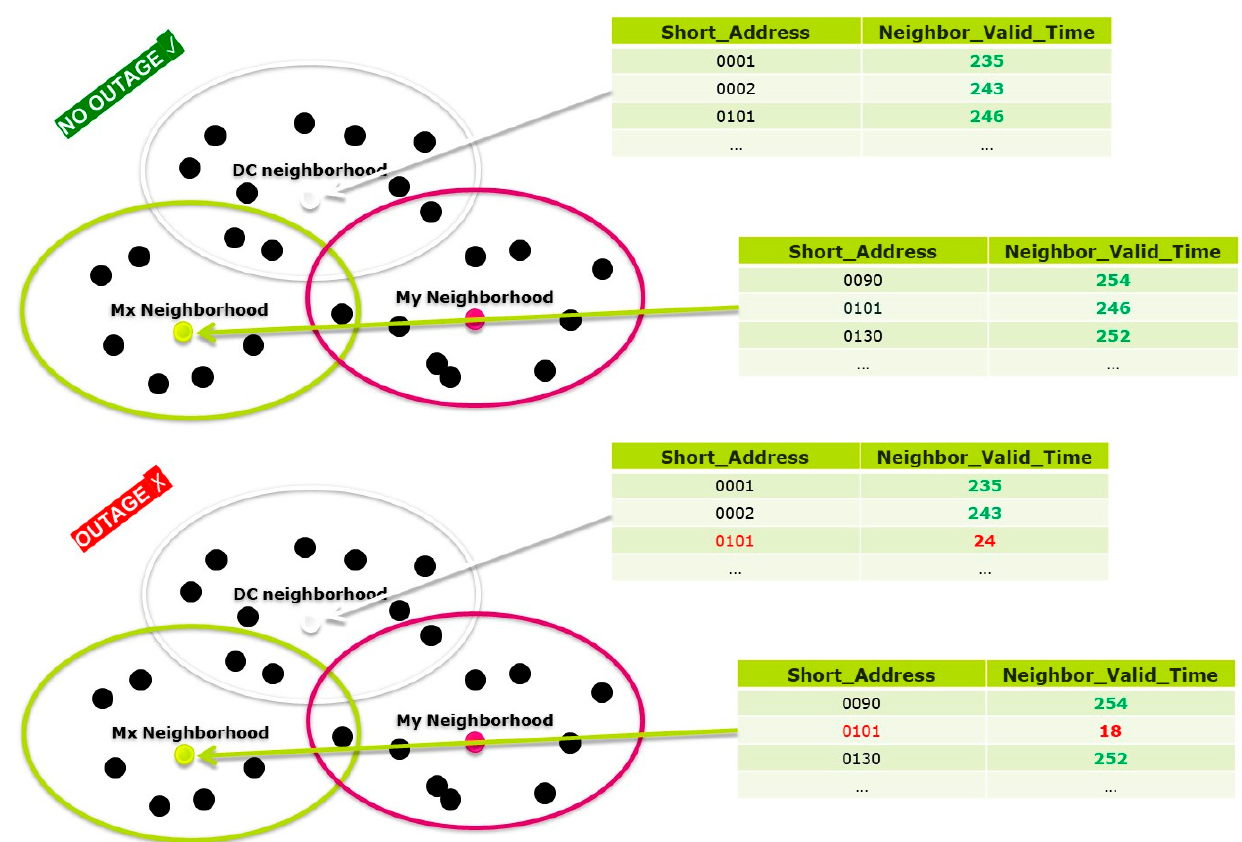
Figure 4. Neighbour tables without repeated deviation ( top ), neighbour tables with repeated deviations ( bottom ).